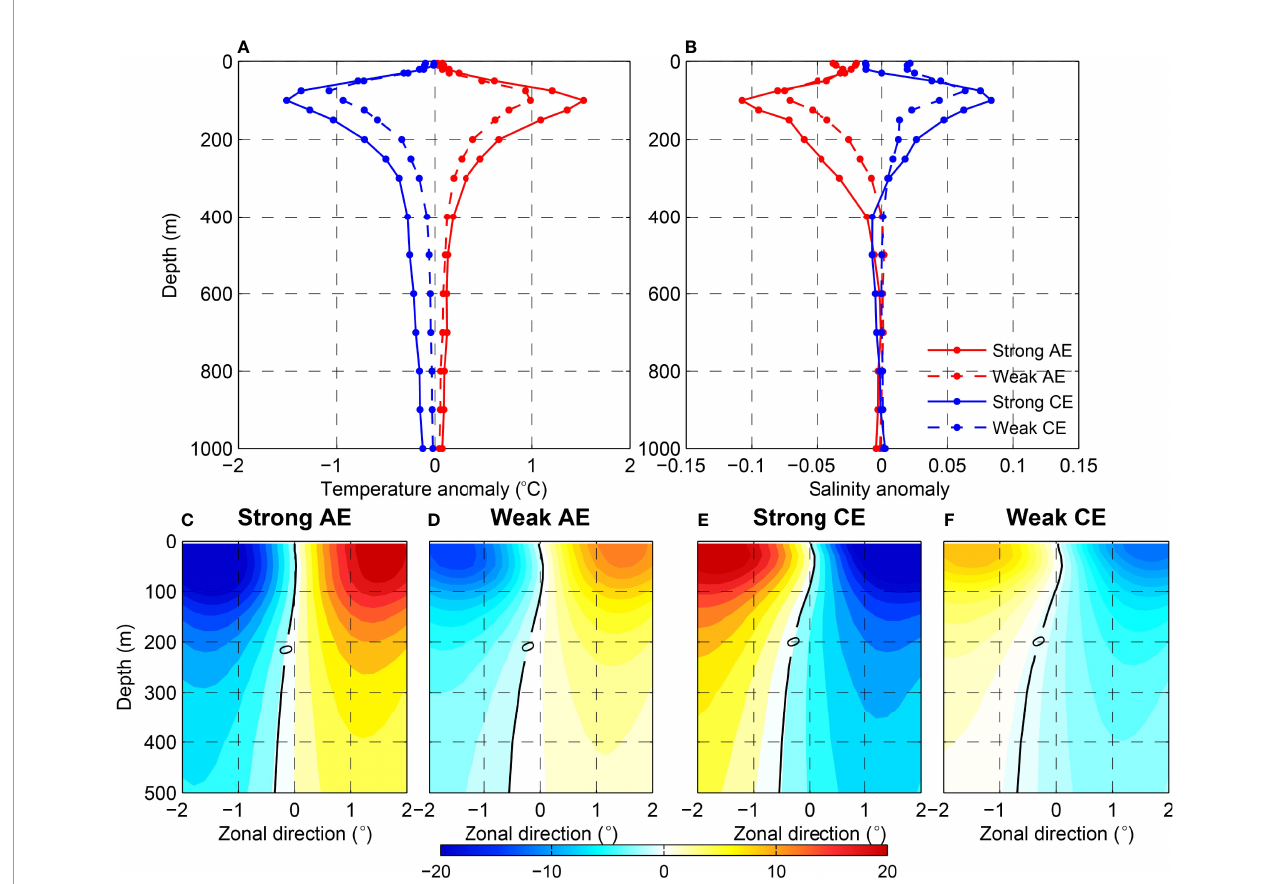
FIGURE 3 | (A) Composite vertical pro fi les of the temperature anomaly (unit: °C) and (B) salinity anomaly associated with eddies. The solid and dashed lines are the pro fi les in strong and weak eddy seasons, respectively. The red and blue colors are for AEs and CEs, respectively. (C – F) Composite maps of meridional current (unit: cm/s) on the vertical section across eddy center for AEs and CEs in the two typical seasons. The positive/negative values stand for northward/southward fl